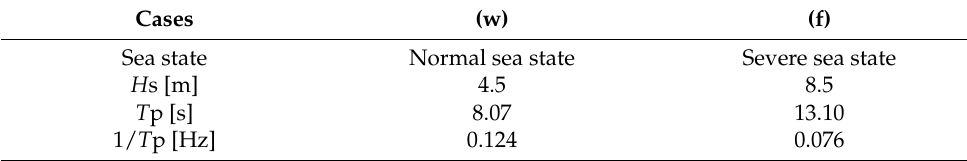
Table 7. Normal sea state and severe sea state conditions.